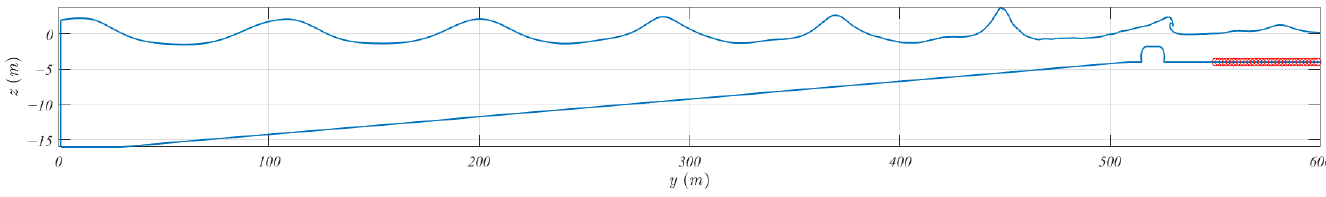
Figure 10. The flume and water surface elevation after running BELWF 8.3 wave periods.